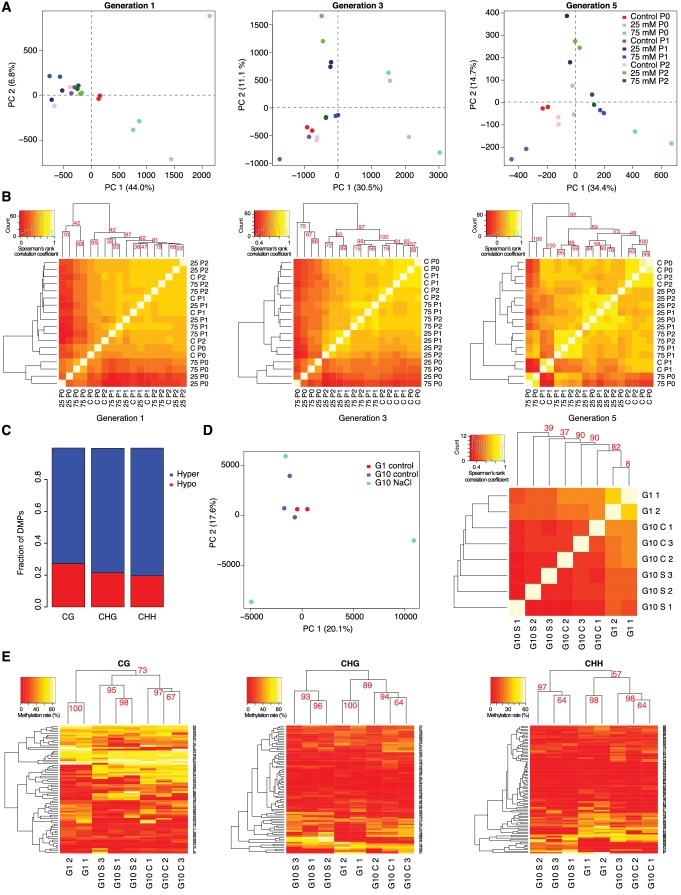
DNA methylation variation after multigenerational hyperosmotic stress.(A) Principal component (PC) analysis of methylation frequencies at DMPs in each generation, with full information across all samples of that generation. Numbers in brackets indicate the percentage of variation explained by the respective PC. (B) Complete linkage clustering of pairwise correlation of DMP methylation frequencies, separated by generation. (C) Fraction of hyper- and hypo-methylated DMPs after salt-treatment of P0 samples. (D and E) Analyses based on data published by Jiang et al. (2014). G1: generation 1. G10: plants after 10 generations of either control of NaCl treatment. (D) Reanalysis of published hyperosmotic stress data (Jiang et al., 2014). PC analysis of methylation frequencies at DMPs (left panel). Bi-hierarchical clustering of pairwise correlation of methylation frequency at DMPs identified in all pairwise comparisons, with full information across all samples (right panel). (E) Reanalysis of previously published hyperosmotic stress data (Jiang et al., 2014). Complete linkage clustering based on DMR methylation frequencies, divided by sequence context. The methylation frequency of each DMR per sample was calculated as the average methylation frequency of cytosines in that DMR. Only DMRs covered in each sample were considered. G1, untreated generation 1; G10, generation 10; C, control; S, salt-treated.